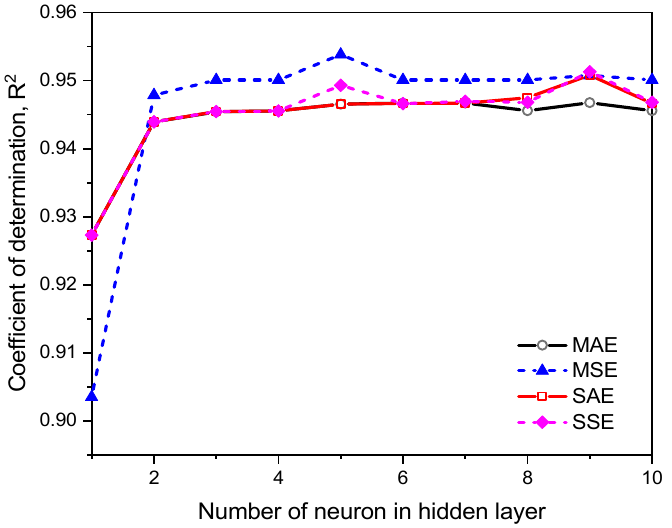
Figure 9. Relationship between R 2 value and number of neurons in the hidden layer according to the performance functions within Bayesian Regularization.